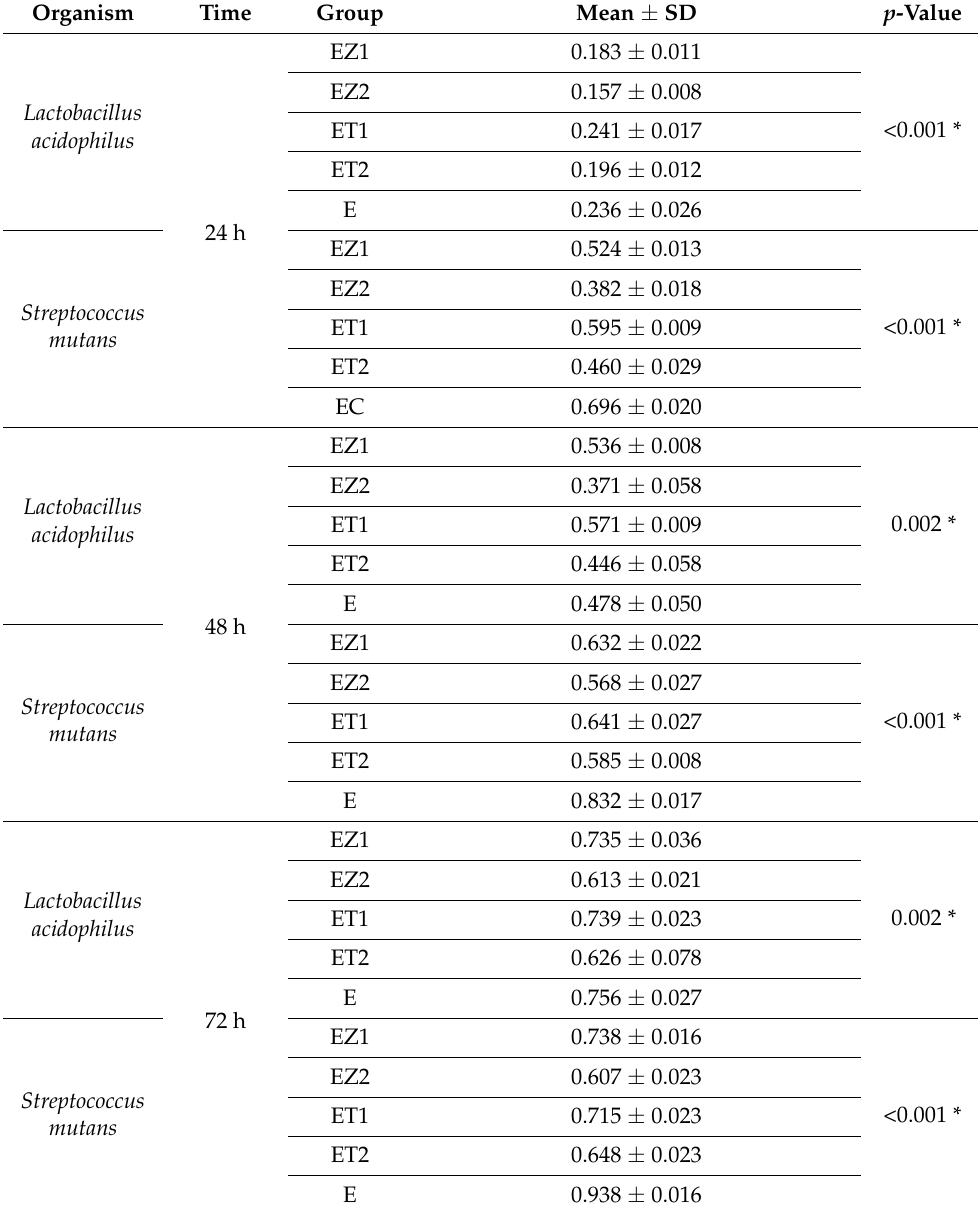
Table 3. Absorbance values of Lactobacillus acidophilus and Streptococcus mutans at 620 nm by ELISA at 24 h, 48 h, and 72